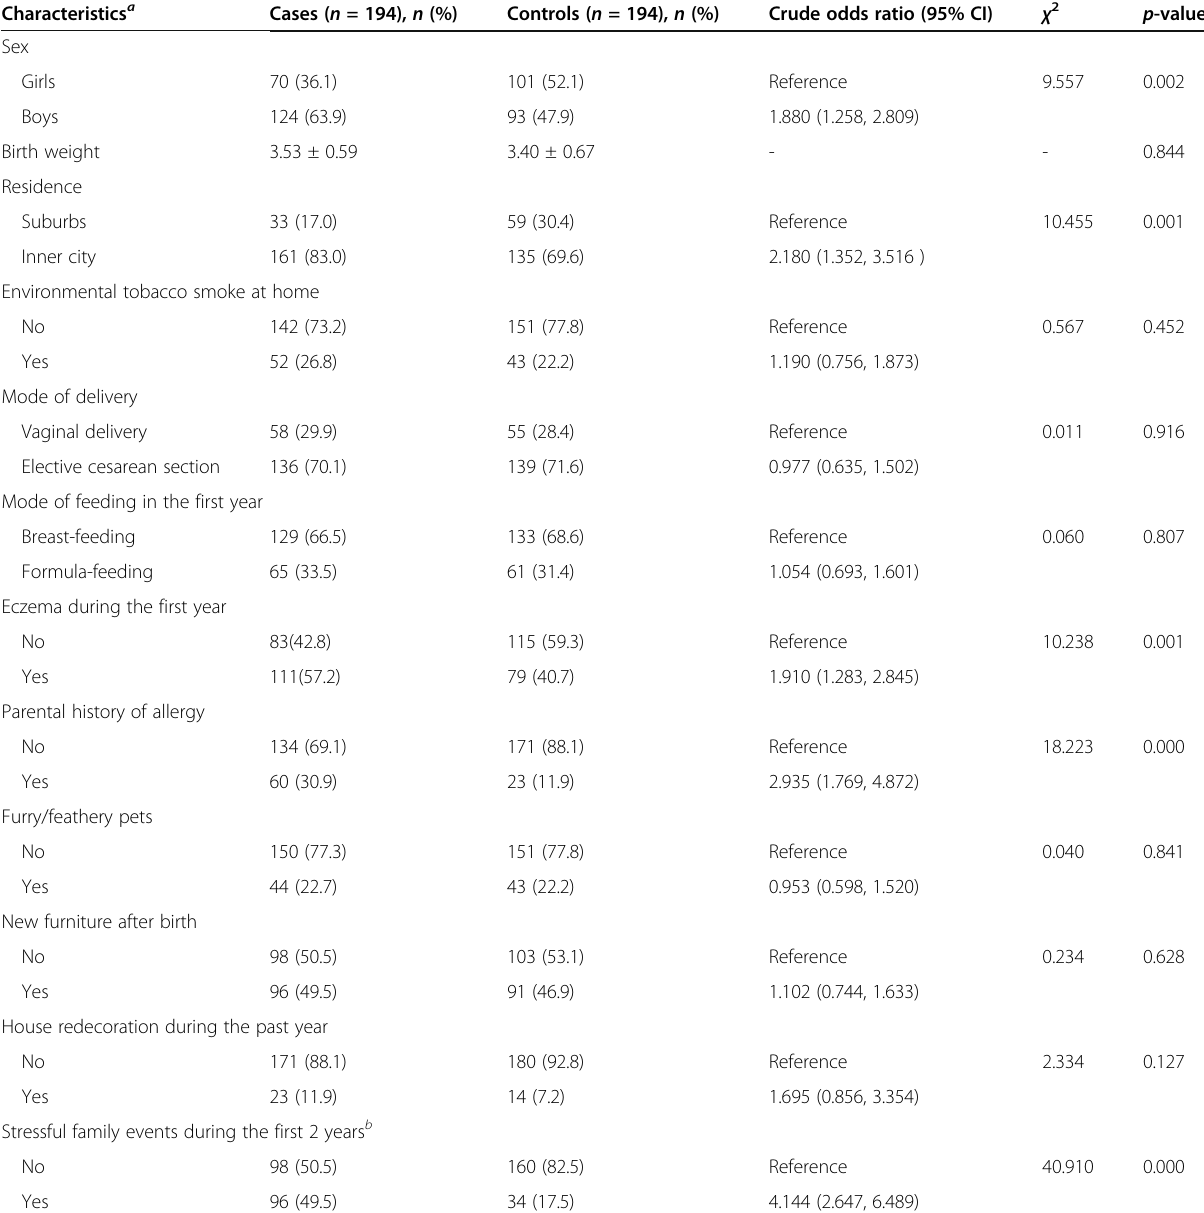
Table 3 Characteristics of children with or without allergic rhinitis ( n = 388) Characteristics